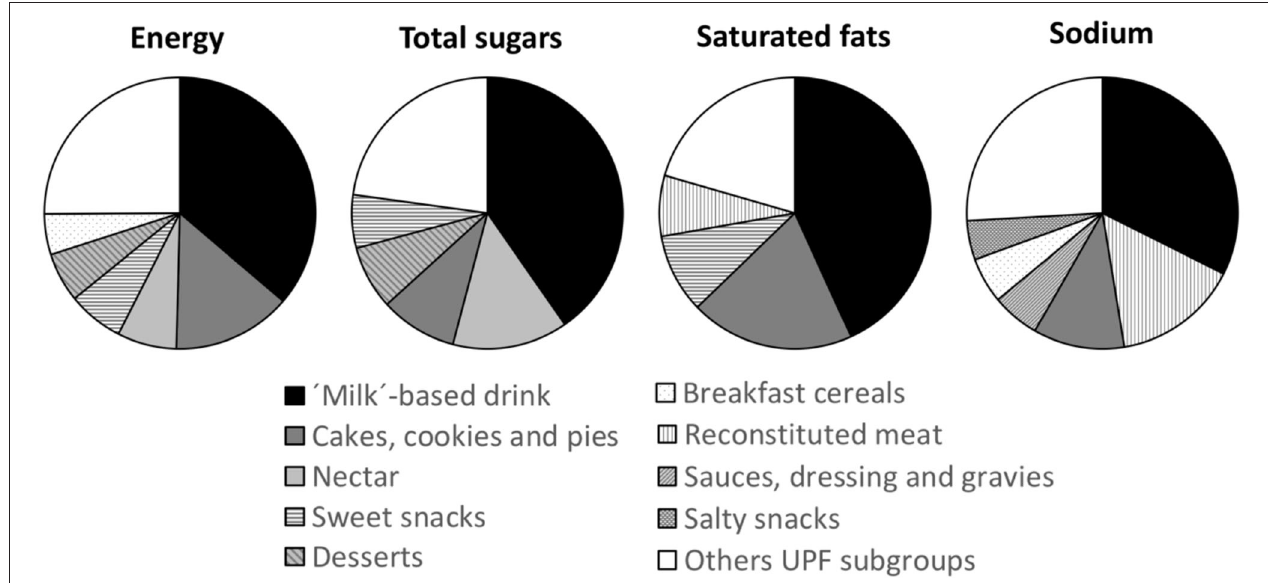
FIGURE 1 | Main food groups contributing to the intake of energy, total sugars, saturated fats, and sodium among ultra-processed food (UPF). Only UPF subgroups contributing to 75% of the intake of energy, total sugars, saturated fats, and sodium are specified.